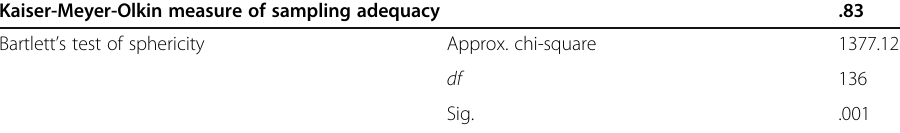
Table 5 KMO and Bartlett ’ s test Kaiser-Meyer-Olkin measure of sampling adequacy .83 Bartlett ’ s test of sphericity Approx. chi-square 1377.12 df 136 Sig.